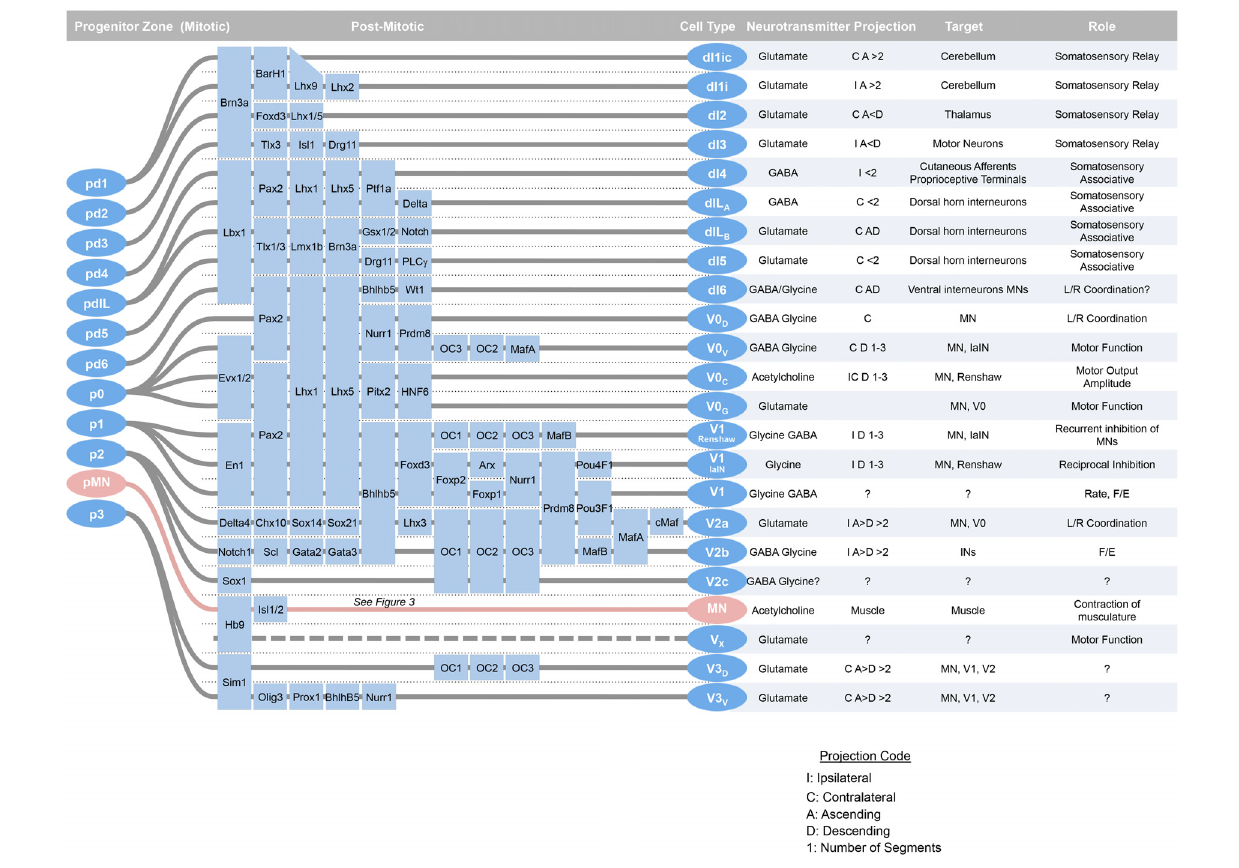
FIGURE 1 | At around mid-gestation, progenitors exit the cell cycle and begin to take up characteristic setting positions, extend axons, and express transcription factors and neurotransmitter biosynthetic enzymes. Over the last week of development, 23 classes of neurons can be defined by transcription factor expression. Adapted from Alaynick et al.